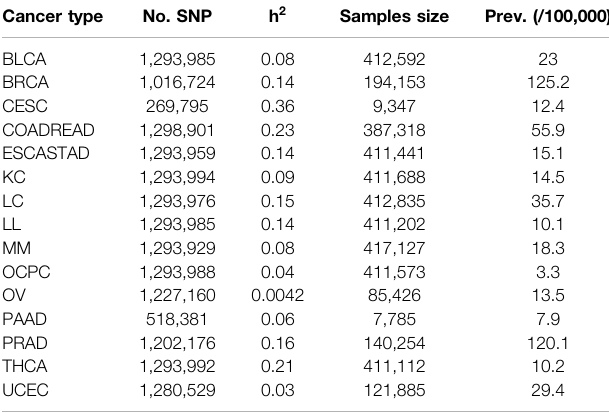
TABLE 1 | Summary of GWAS summary statistics in 15 types of cancer. Cancer